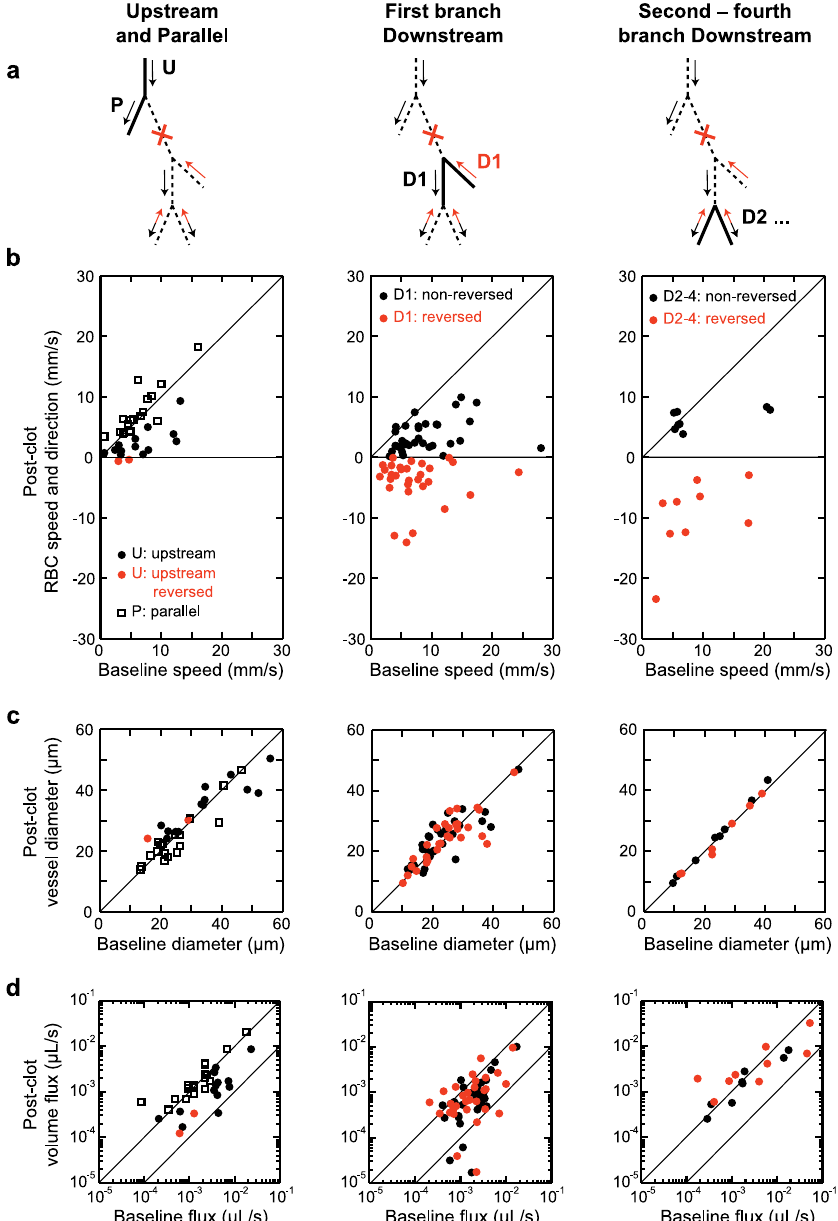
Figure 6. Compendium of Flow Changes following Localized Photothrombotic Clotting of Communicating Surface Arterioles (A) Illustration of the four different classes of vessels considered, each delineated by their connectivity to the target vessel (indicated by an X). (B) Plots of post-clot RBC speed as a function of baseline RBC speed for each vessel class. The post-clot and baseline speeds were significantly correlated for the upstream and parallel vessels, but uncorrelated for the downstream vessels (Table 1). (C) Plots of post-clot vessel diameter as a function of baseline diameter. The pre- and post-clot diameters were correlated for all cases (Table 1). (D) Plots of post-clot volume blood flux as a function of the baseline value. The diagonal lines represent post-clot flux levels of 10% and 100% of baseline. As for the diameters, the pre- and post-clot fluxes were correlated for all cases (Table